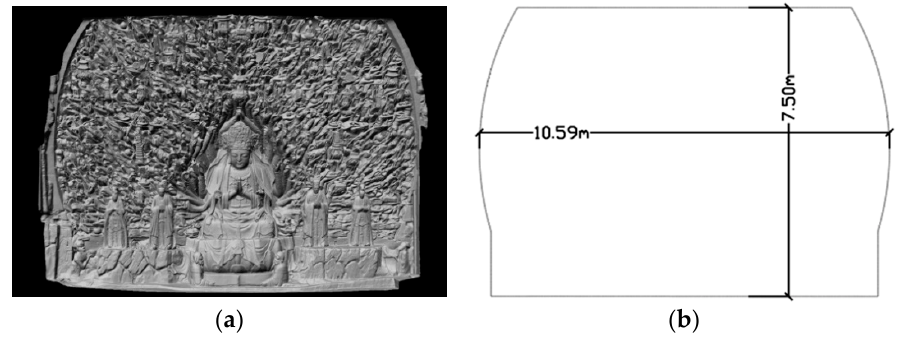
Figure 5. Geometric information of the Dazu Thousand-Hand Bodhisattva statue: ( a ) orthophoto quad; and ( b ) dimensions of statue model.